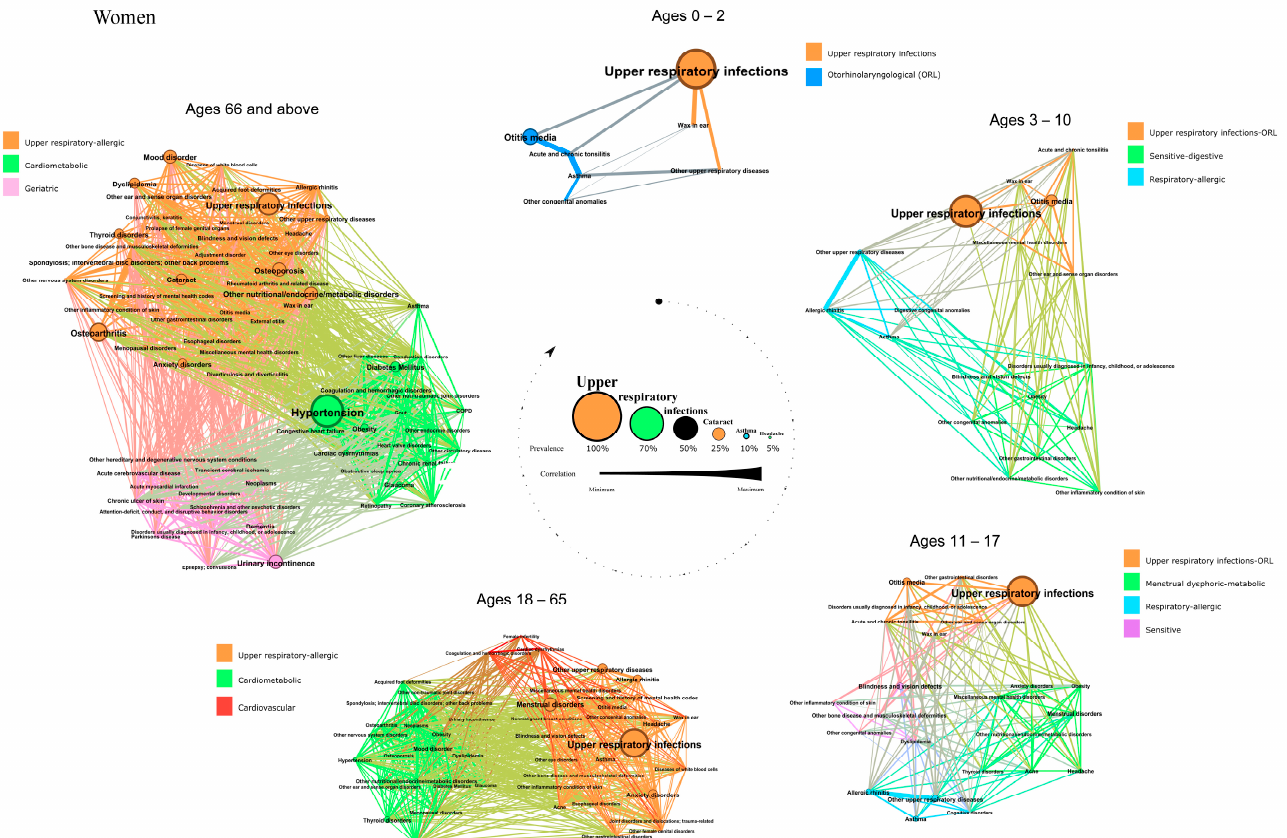
Figure 2. Comorbidity patterns in the networks of women with AD based on age. The diameter of each node and the label size are proportional to the disease prevalence. The width of each link is proportional to the correlation between disease. The colors of the nodes correspond to different